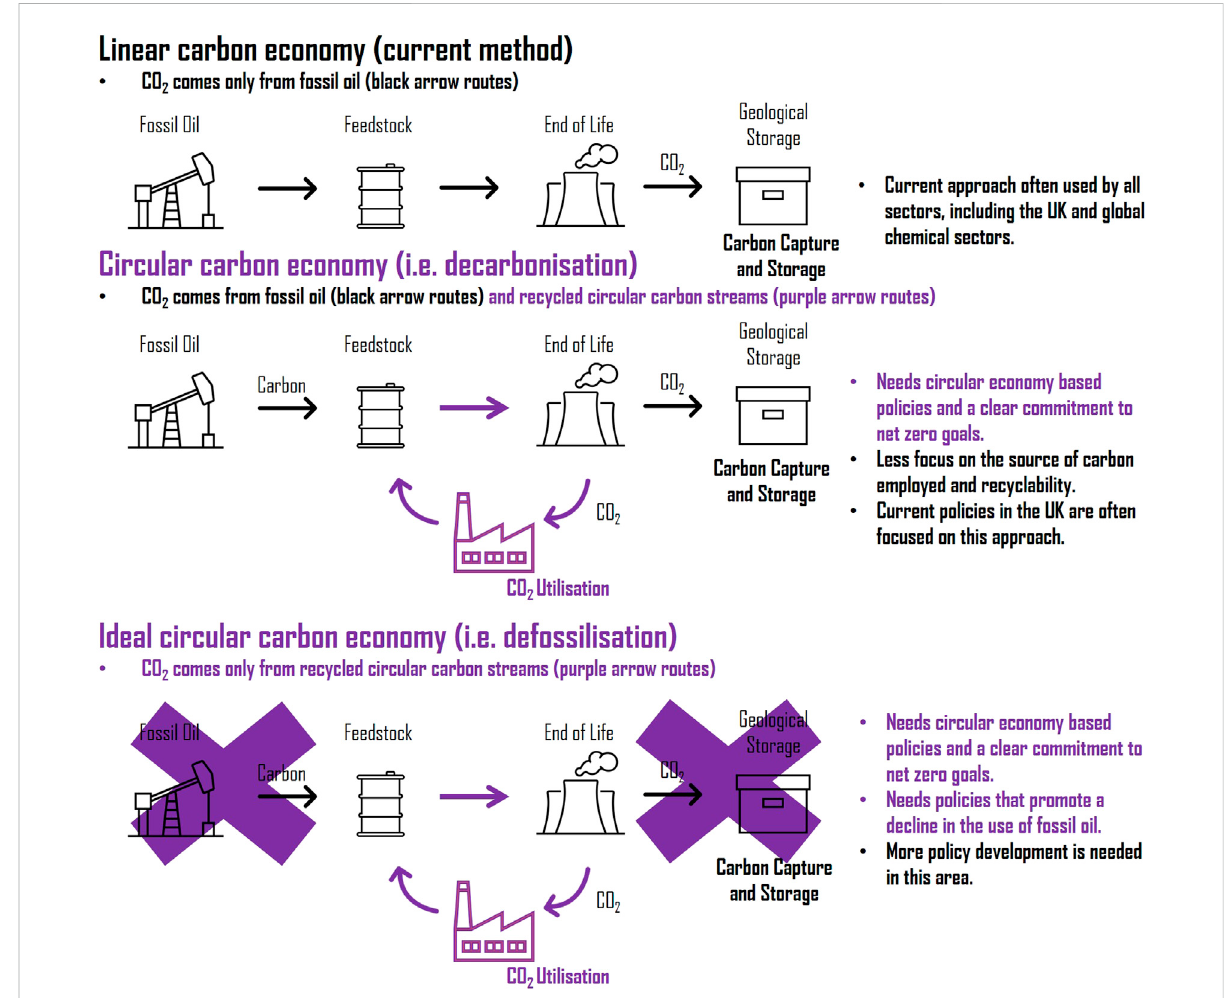
General concept of employing a circular carbon economy (and thus a circular chemical economy) vs the linear carbon model currently employed in the UK chemical sector. This fi gure also comments on policy changes we propose are needed to increase carbon circularity in the UK (and global) chemical